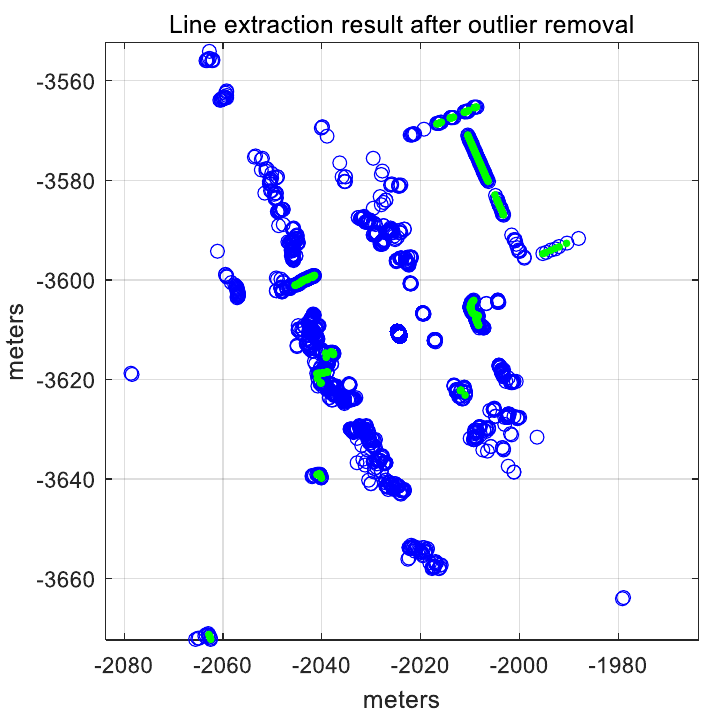
Figure 14. Line extraction result from LIDAR points (after outlier removal).